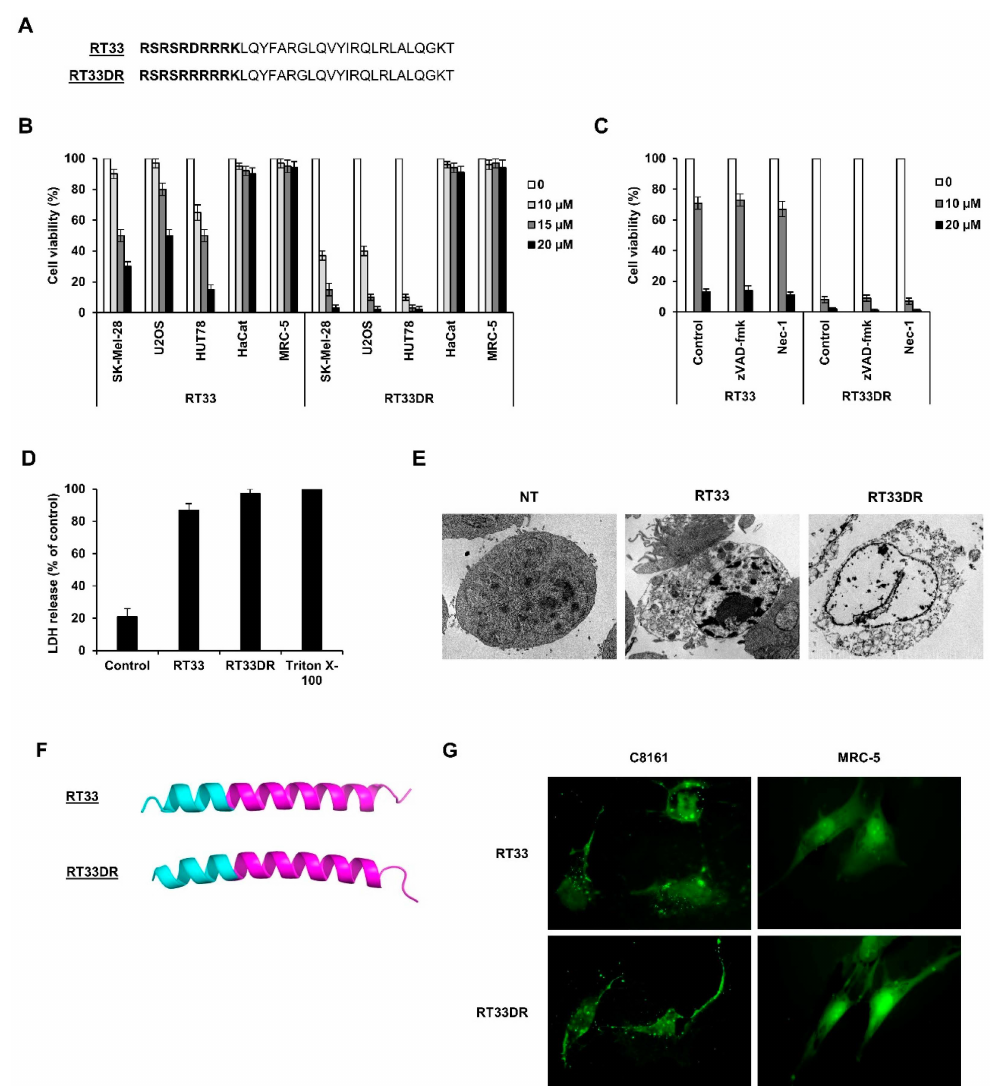
Figure 6. RT33 and RT33DR induces cancer cells, but not normal cells, death. ( A ) Amino-acid sequence of RT33 and RT3DR. hAP10 and hAP10DR sequences are in bold. ( B ) The indicated cells were exposed to increasing concentrations of RT33 or RT3DR for 20 h. Viability was then assessed by an MTT assay. Data are means ± s.e.m. ( n = 3). ( C ) HUT78 cells were exposed to increasing concentrations of RT33 or RT3DR for 20 h in the presence and absence of 50 µ M zVAD-fmk or 50 µ M Necrostatin-1 (Nec-1). Viability was then assessed by an MTT assay. Data are means ± s.e.m. ( n = 3). ( D ) HUT78 cells were exposed to 20 µ M of RT33 or RT33DR for 3 h. Necrotic cell death was monitored by lactate dehydrogenase (LDH) as in Figure 4B. Data are means ± s.e.m. ( n = 3). ( E ) Ultrastructural analysis of HUT78 cells untreated (NT) or treated with 15 µ M of hAP10 or hAP10DR for 1 h. ( F ) Structural prediction of RT33 and RT33DR. The segments corresponding to the hAP10 and hAP10DR moieties are in magenta. ( G ) C8161or MRC-5 cells were exposed to FITC-labelled RT33 or RT33DR for 1 h. Cells were then examined by fluorescence